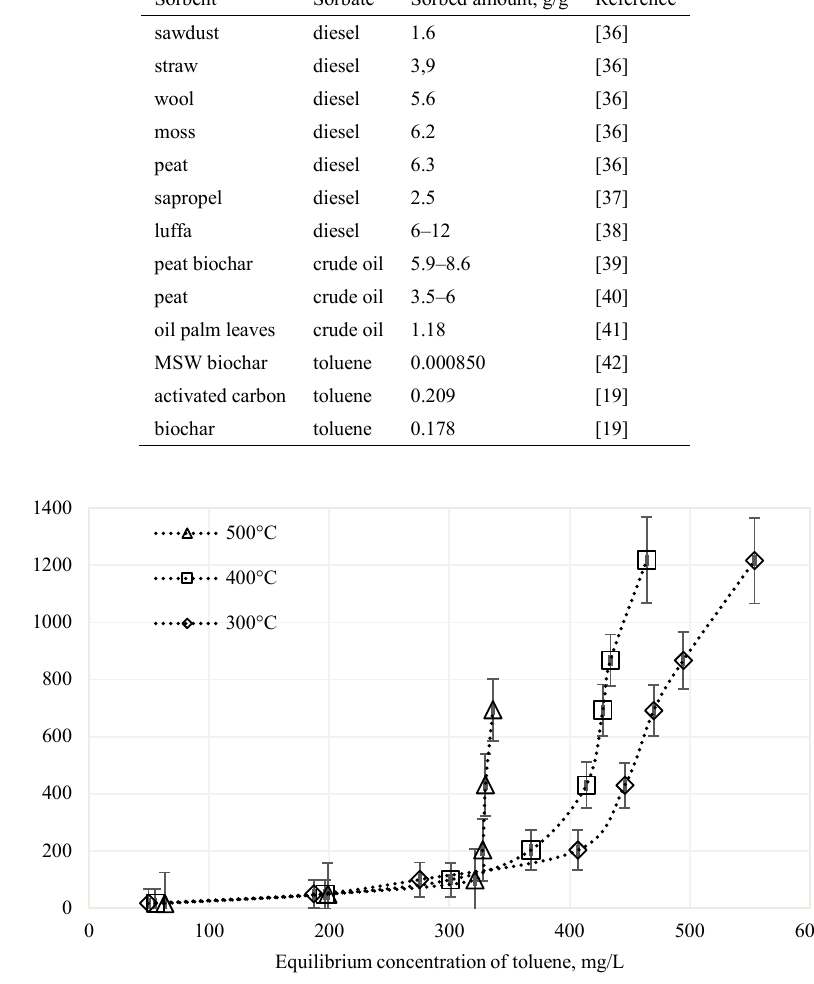
Fig. 5 Toluene sorption on biochar, sorption time 24